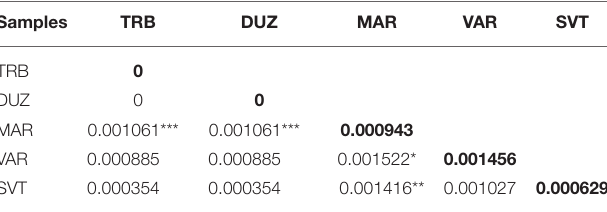
FIGURE 5 | Neighbor-Joining tree based on sequence analysis of the COIII region. Bootstrap values of 1,000 replications are given on nodes in percentages. The abreviations of the samples were given in Figure 1 .